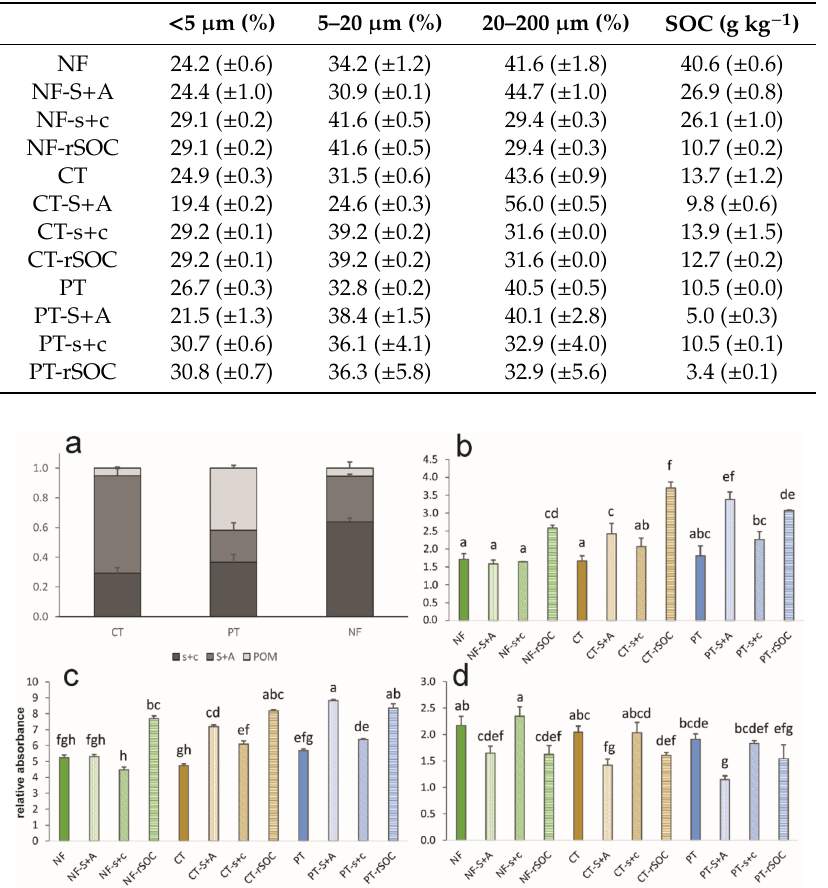
Figure 2. Total organic carbon distribution of the investigated Luvisol under various land uses ( a ). The aromaticity index ( b ), the relative absorbance at 1794 cm -1 referring to the oxidation degree ( c ), the clay / quartz index ( d ), and values of the fractions. Di ff erent letters above the bars indicate the significant di ff erence at p < 0.05 (CT: conservation tillage; PT: ploughing tillage; NF: native forest; S + A: sand and aggregates; s + c: fine fraction ( < 20 µ m); POM: particulate organic matter; rSOC: resistant part of organic carbon attached to s +